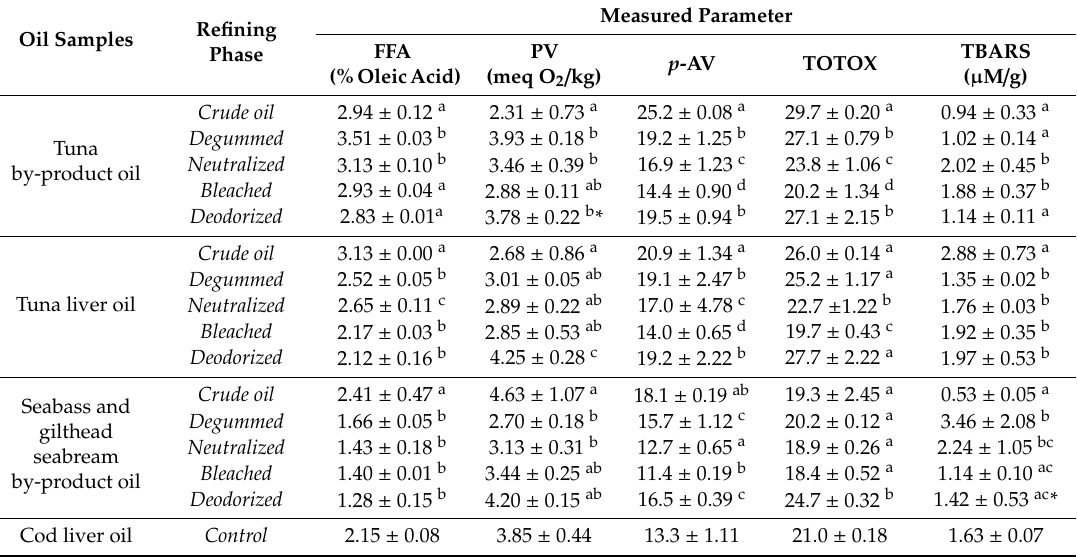
Table 1. Chemical and quality parameters of crude oils from tuna by-products, tuna liver, seabass and gilthead seabream by-products at di ff erent stages of the refining process, and cod liver oil